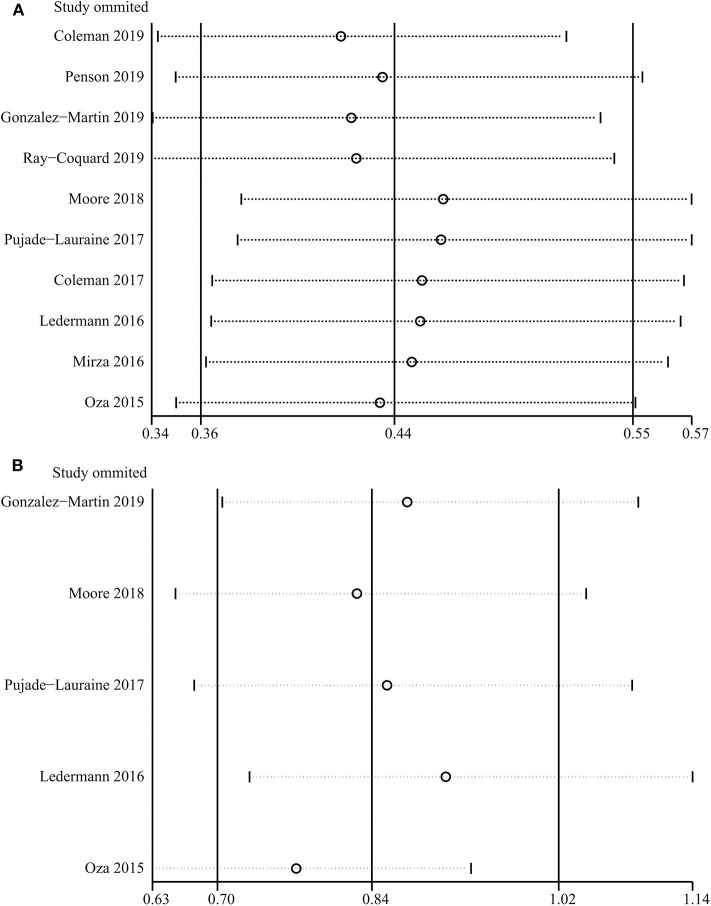
Sensitivity analysis of progression-free survival (A) and overall survival (B) based on leave-one-out approach.